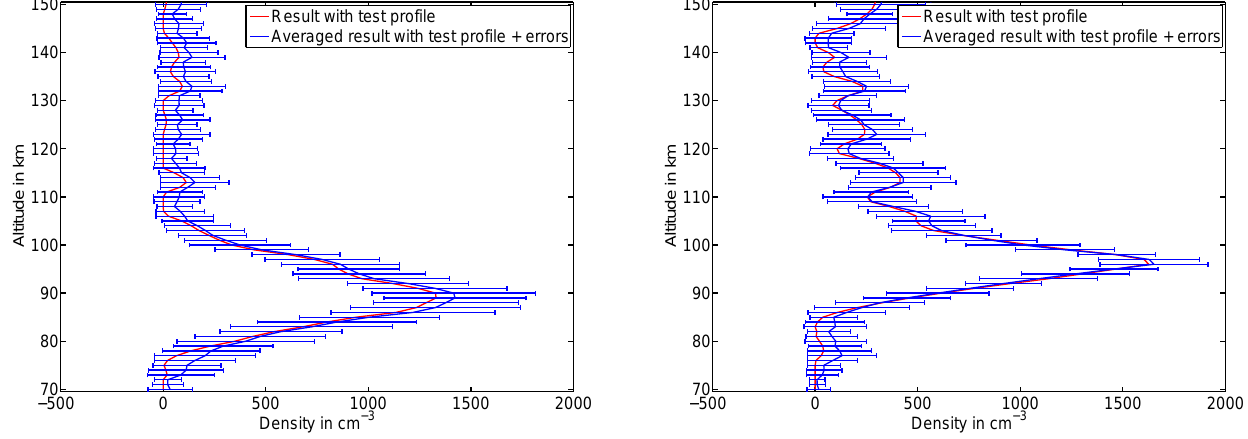
Fig. 21. Plot of retrieved Mg (285.2nm) for the 4yr averaged equa- torial data set (red). To estimate the error, the retrieval is repeated 1000 times with a typical random Gaussian error for daily aver- aged data applied to the initial slant column densities. The blue line shows the mean result of the 1000 runs, while the error bars show the standard deviation from the mean values of the 1000 runs. For daily averaged data (which are used here) the differences between both methods are small.